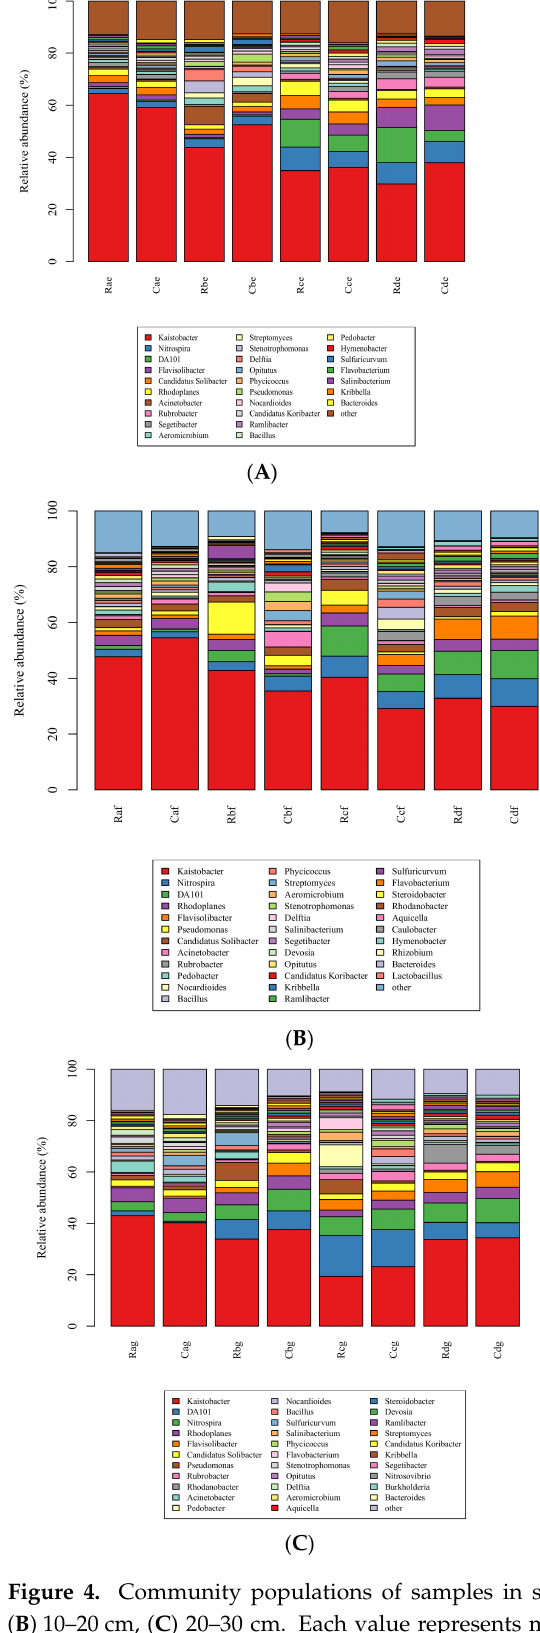
Figure 4. Community populations of samples in soil layers at the genus level. ( A ) 0–10 cm, ( B ) 10–20 cm, ( C ) 20–30 cm. Each value represents mean ± SD ( n = 3). R, C indicate atrazine at recommended dose in AT and CK, respectively; a, b, c, d indicate soil samples at 1, 7, 21, and 119 d, respectively; e, f, g indicate 0–10, 10–20, and 20–30 cm soil levels,